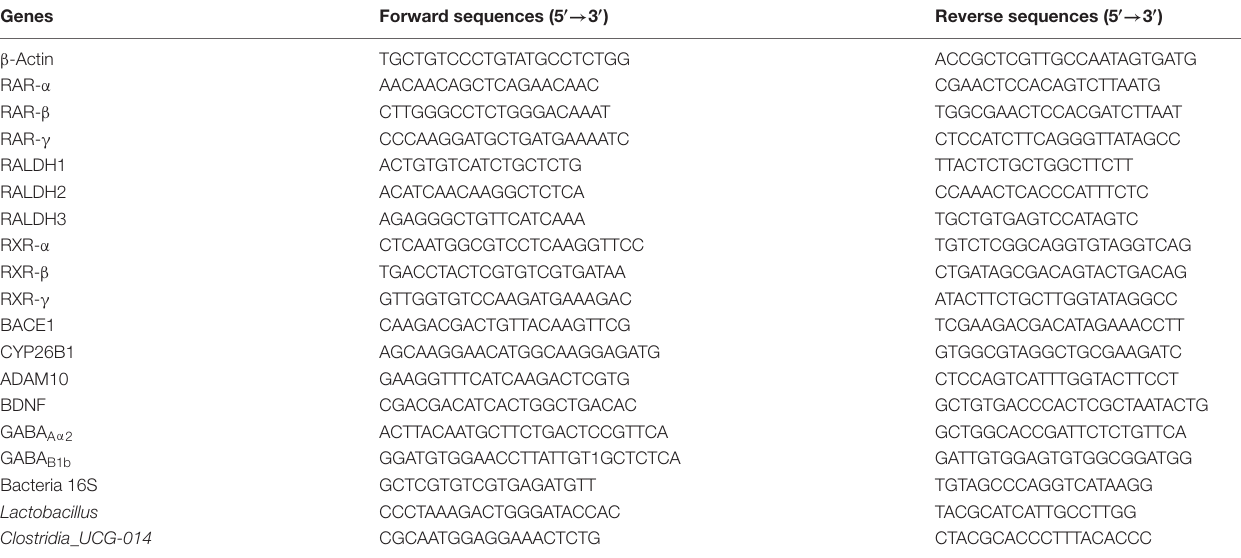
TABLE 1 | The sequences of primers used in the present study. Genes Forward sequences (5 (cid:48) → 3 (cid:48) ) Reverse sequences (5 (cid:48) → 3 (cid:48)